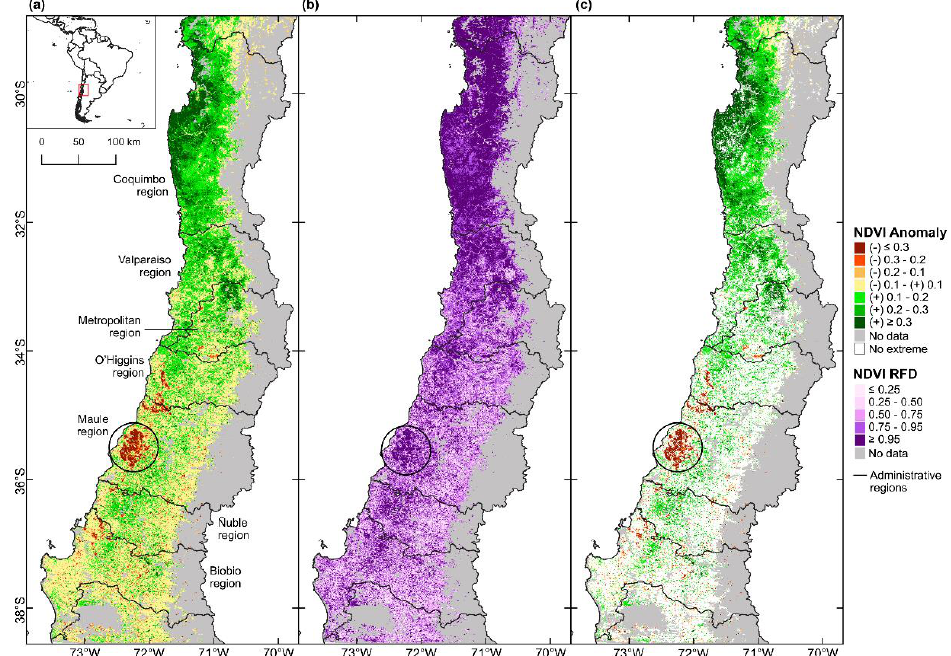
Figure 6. Extreme positive anomalies of the Normalized Difference Vegetation Index (NDVI) re- lated to abnormally high precipitation in Central and Northern Chile. Calculations were performed using the ExtremeAnoMap function of the “npphen” R-package and MOD13Q1 data from the Terra satellite and considered 239 NDVI scenes of the 2000–2009 period as a reference. The maps correspond to 26 June 2017 and show ( a ) NDVI anomalies, ( b ) the position of the NDVI observations within the reference frequency distribution (RFD), and ( c ) NDVI anomalies at RFD >= 0.95. The “extreme” NDVI anomalies shown in panel ( c ), defined by RFD >= 0.95, are NDVI records falling among the 2.5% range of the highest NDVI values of the reference period. The circled area corre- sponds to the extreme negative anomaly due to the mega- fire of January 2017, known as “tormenta de fuego”.